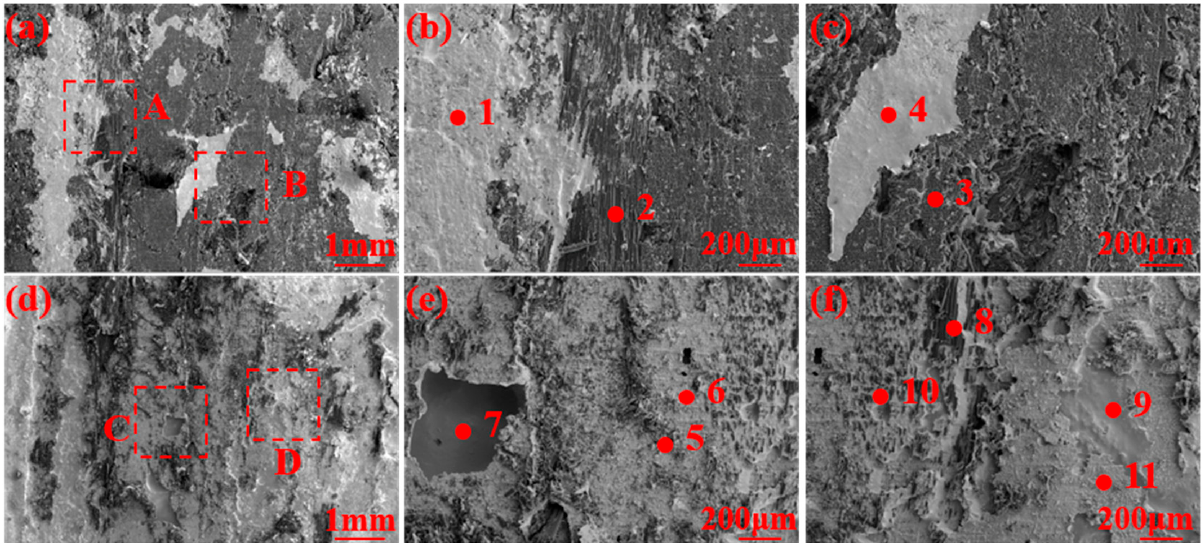
Figure 11. The fracture surfaces with the welded joints: ( a ) C/C composites side, ( b ) the magnified image of A area, ( c ) the magnified image of B area, ( d ) Cu side, ( e ) the magnified image of C area, ( f ) the magnified image of D area. Table 4. EDS results of marked points in Figure 11 (at.%).